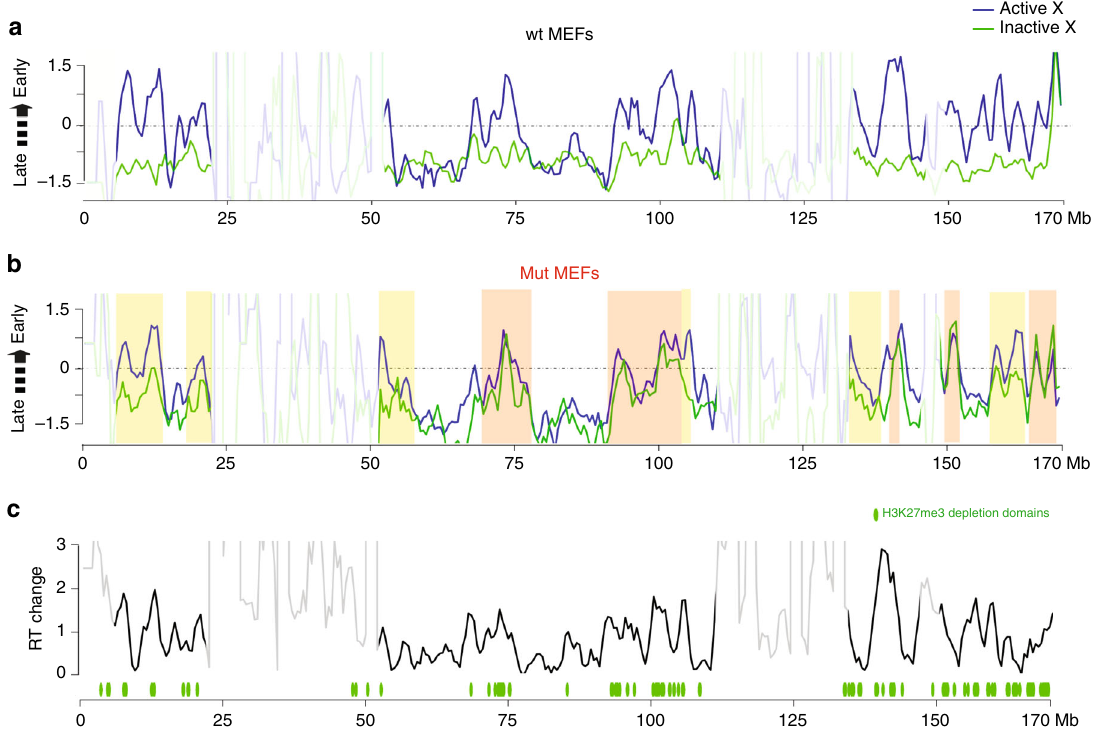
Fig. 4 Advanced Xi replication timing in SmcHD1 mutant MEFs. Allele-speci fi c Repli-seq pro fi les of wt ( a ) and germline SmcHD1 mutant (mut) ( b ) MEFs. Z-score of ratio of read densities from asynchronously dividing cells in S-phase to the read densities of G1 cells, 500 kb bins. Higher Z-score value corresponds to earlier replication. Boxes represent examples of regions in which replication timing on Xi and Xa in germline SmcHD1 mutant cells are equivalent (orange), or moderately advanced/equivalent to wt Xi (yellow). Regions of low probe mappability are indicated with reduced transparency. c Difference in the replication timing (Z-score of G1/S read densities) shift between Xa and Xi in wt and mut MEFs within and outside H3K27me3